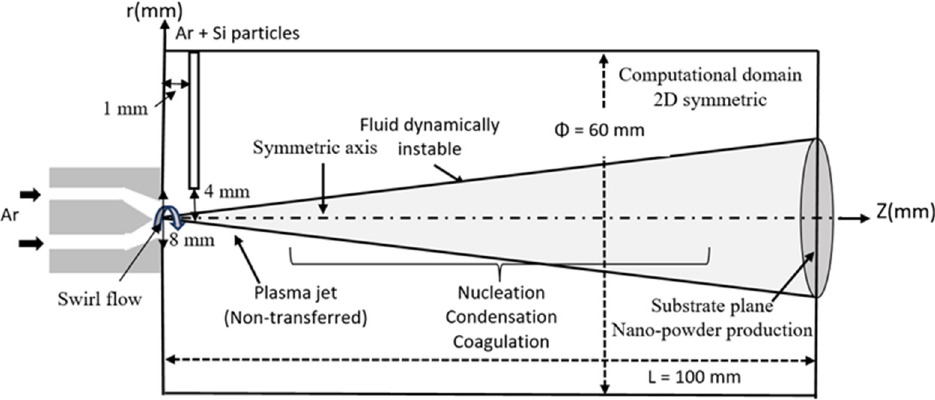
Figure 3. Schematic diagram of nanopowder production with a non-transferred thermal plasma jet.